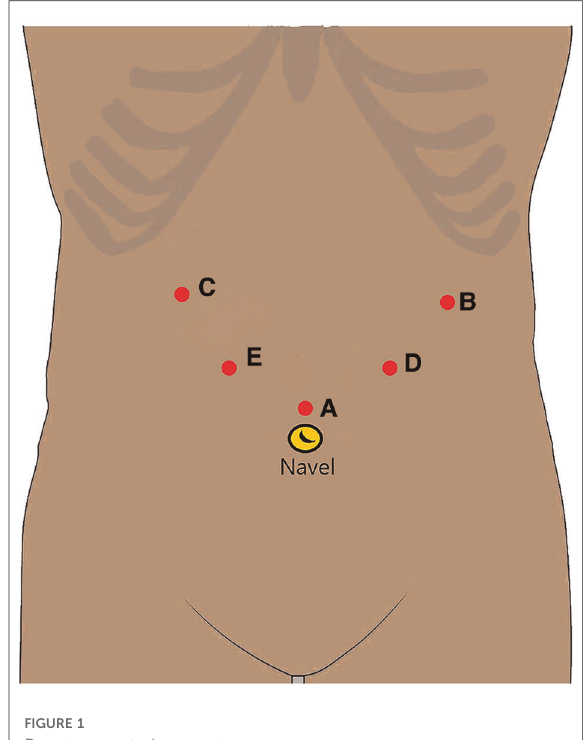
FIGURE 1 Puncture port